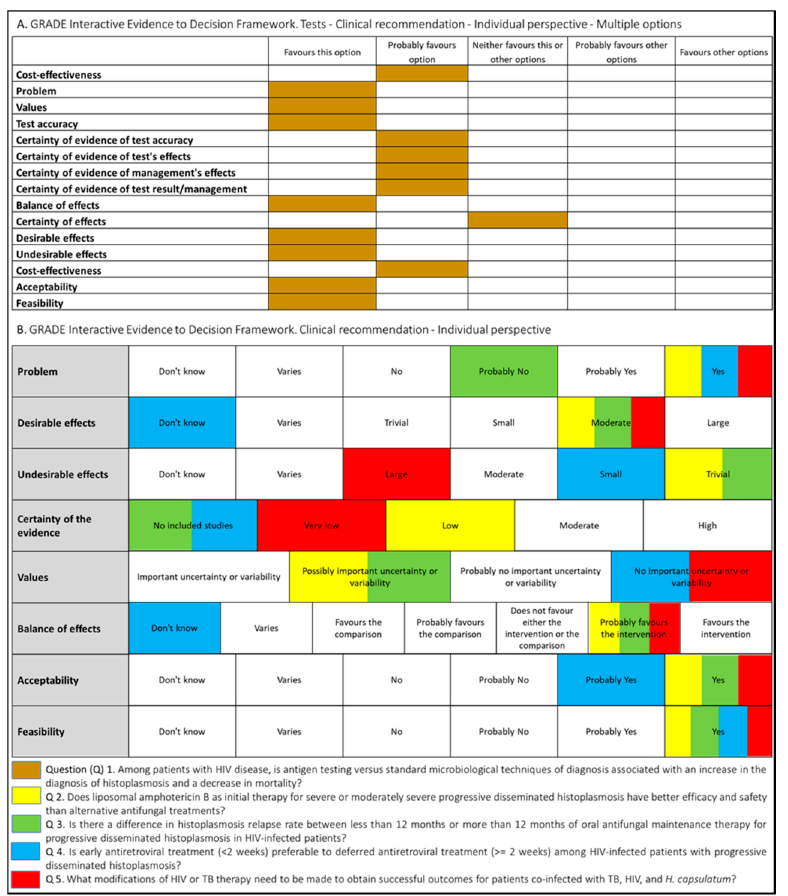
Figure 1. Summary of judgment of questions proposed for the development of the guidelines for diagnosing and managing disseminated histoplasmosis among people living with